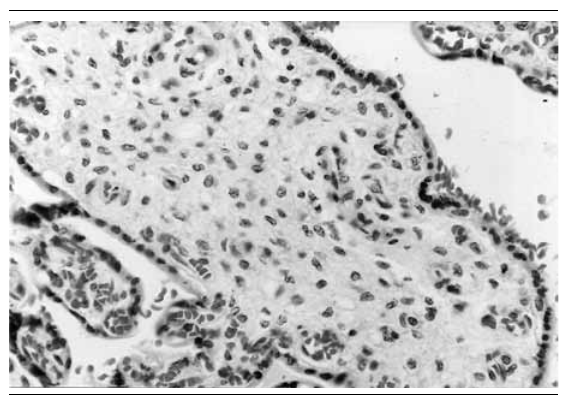
figurE 3 – Microscopy (HE): immaturity - villous stromal hypercellularity. 40 × / 0.65 HE: hematoxylin and eosin.